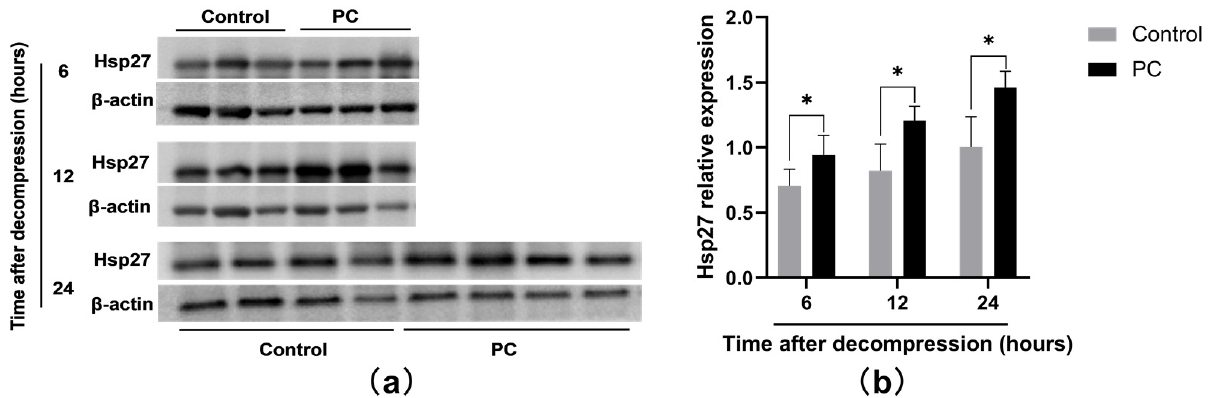
Figure 4. Hsp27 expression of PI wounds at 6, 12, and 24 h. ( a ) Western blot analysis of Hsp27 of the two groups. ( b ) Hsp27 relative expression of the two groups. * p < 0.05. PC: preconditioning.